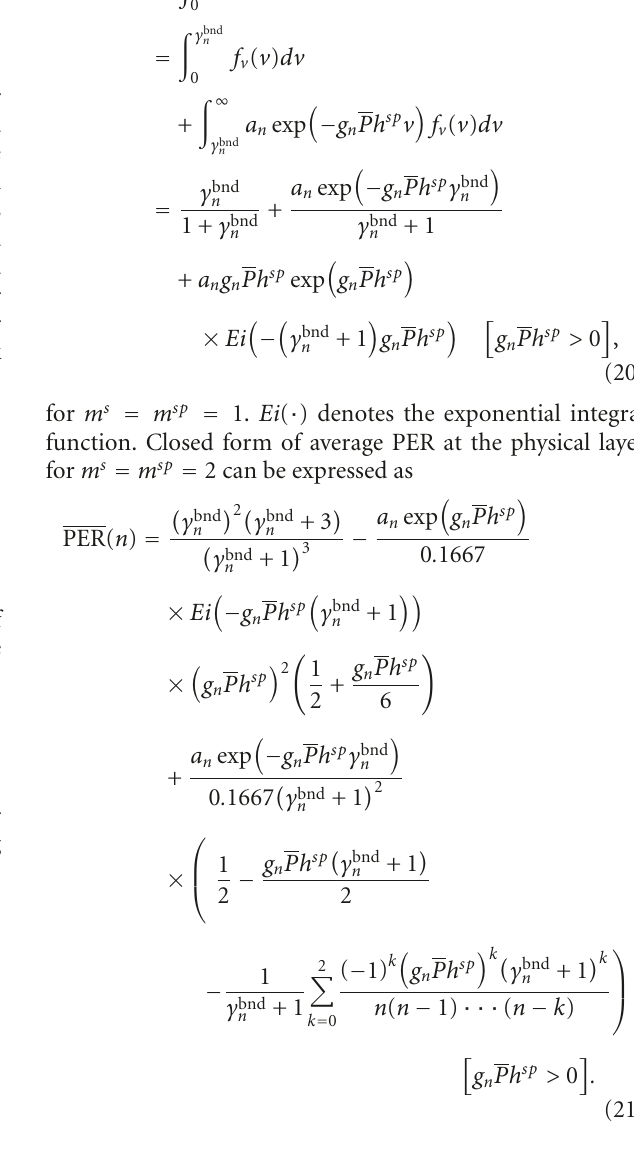
Figure 3: Proof of Slater’s condition